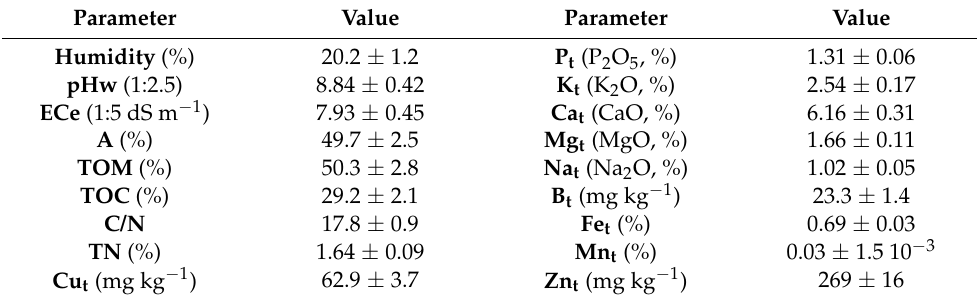
Table 1. Organic amendment analysis (sheep and poultry